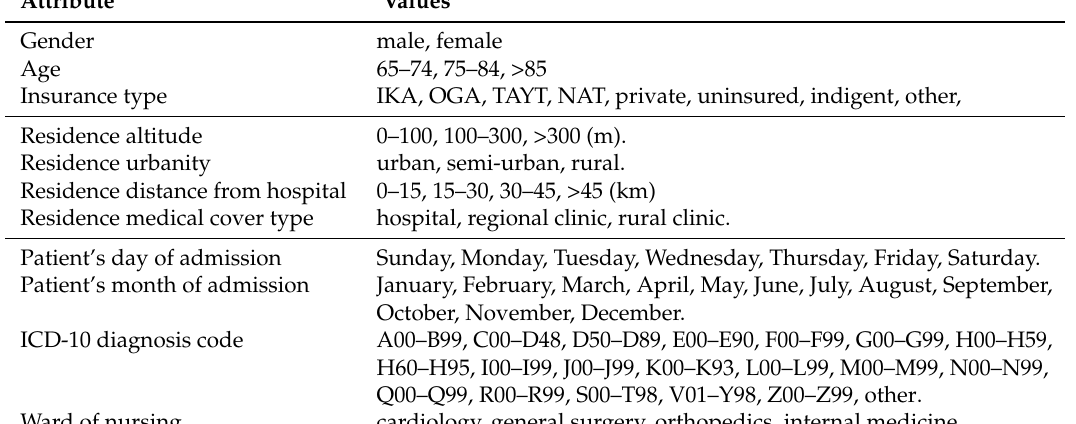
Table 1. Attributes description.